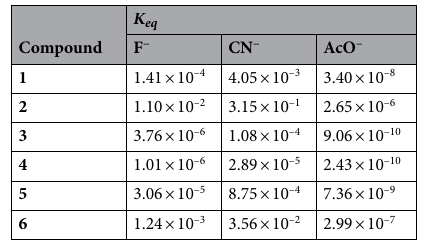
Table 9. Equilibrium constants ( K eq ) for compounds 1 – 6 proton dissociation equilibrium between sensors and anions (F − , CN − , and AcO −